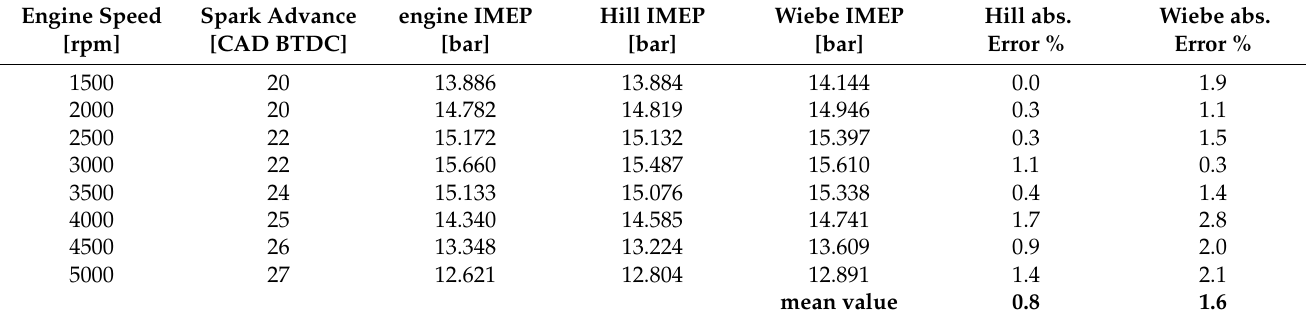
Table 15. Experimental and simulated IMEP with absolute prediction errors (80% NG; MAP = 1.6